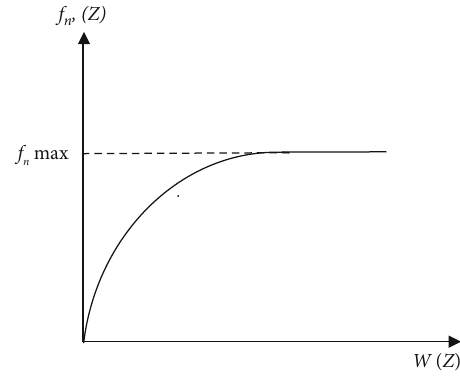
Figure 3: Constitutive model of shaft wall and surrounding strata.